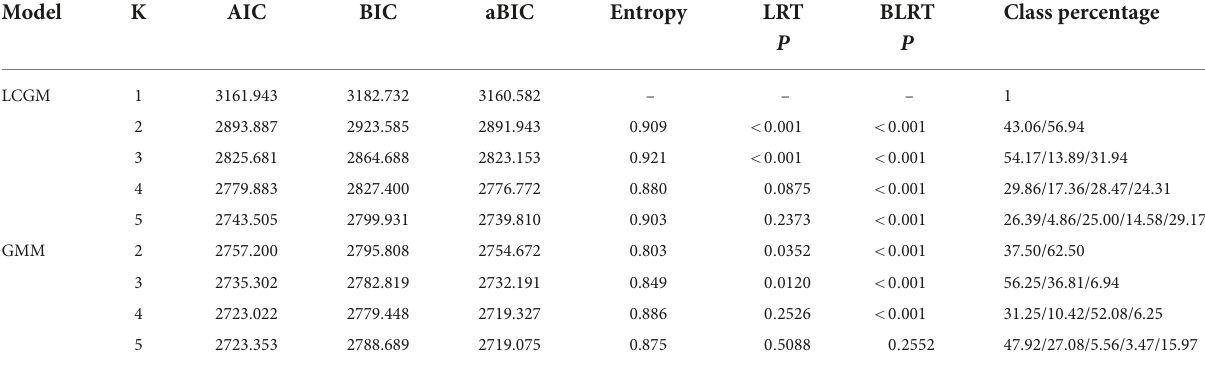
TABLE 1 The results of model fitting ( n = 144).